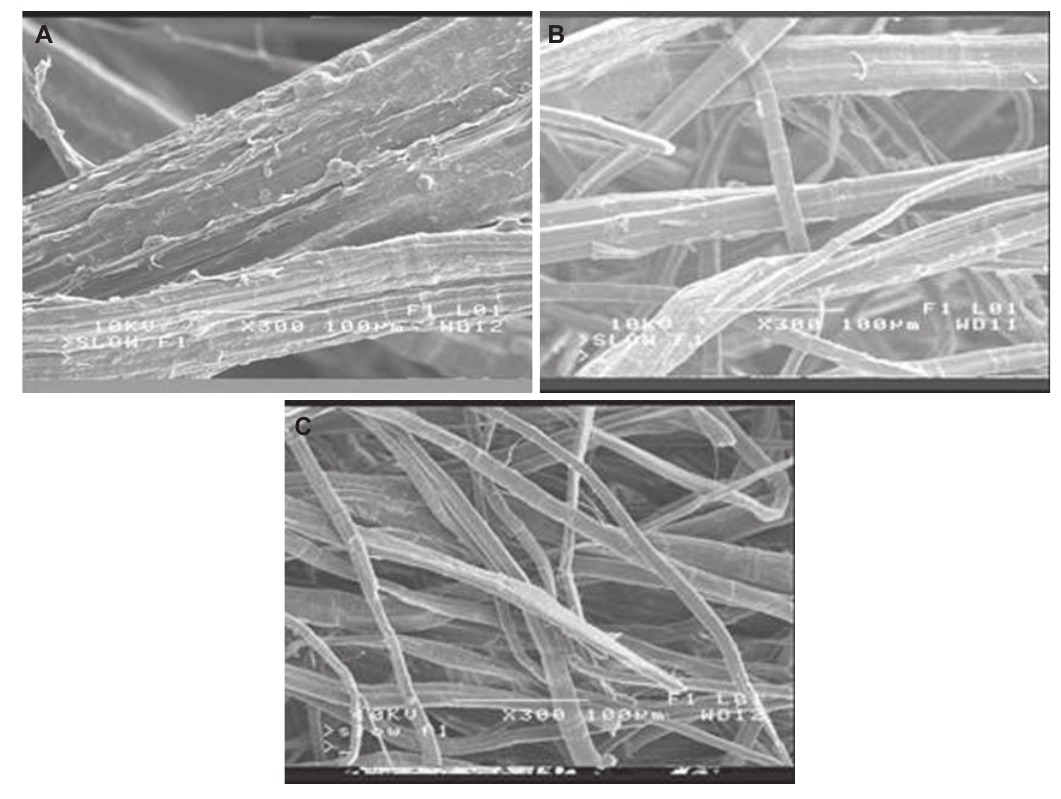
Figure 1 (A) Flax fi ber from F10 without any treatment; (B) F0; (C) F0-NaOH.